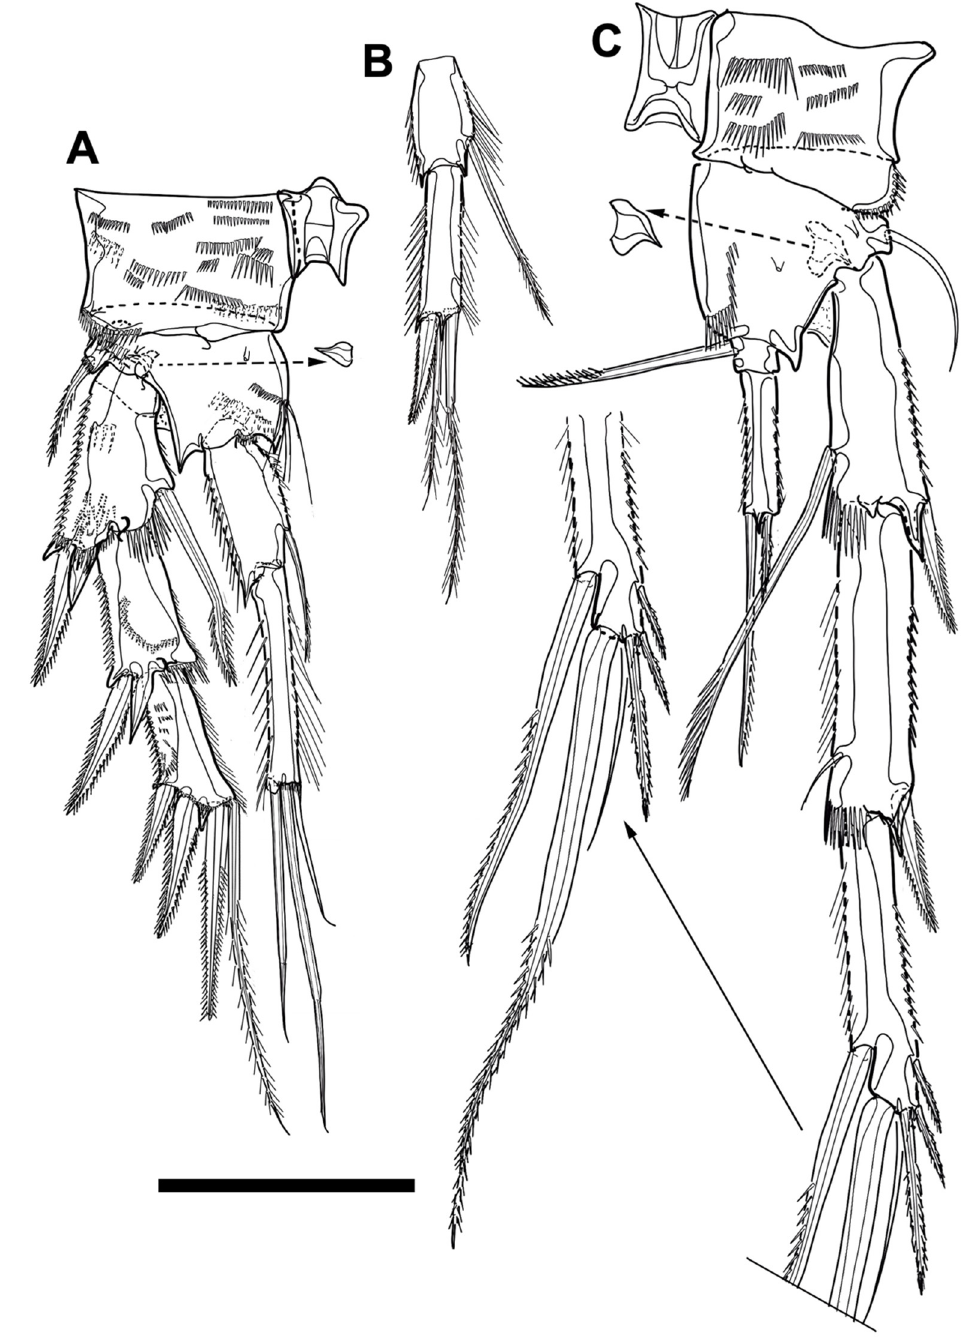
Figure 19. Line drawings of Phyllopodopsyllus saywakimi sp. nov. male (paratype 14): ( A ) P2; ( B ) en- dopod of P3; ( C ) P4. Scale bar: 50 µm. ( B ) endopod of P3; ( C ) P4. Scale bar: 50 µ